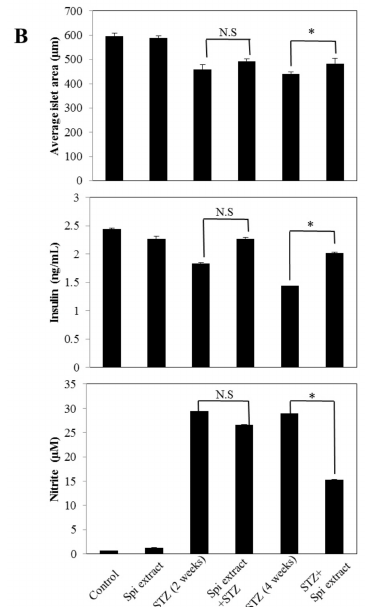
Figure 7. Spirulina extract protects islets from STZ-induced destruction. Type 1 diabetes was induced in Wistar rats through injection of STZ. ( A ) The cellular morphologies of islets were determined through staining with H&E. Islets were labeled with insulin antibody and nitrotyrosine antibody, and then examined by microscopy; ( B ) The size of islets was determined by IMT i-solution software. Levels of insulin and NO production in the serum were determined. Values are expressed as the mean ± SEM for six animals in each group. The two-sample t -test was used to compare the results between the control group and treatment group. N.S = Not significant. * p < 0.05, significant difference between the STZ-injected groups and the Spi extract + STZ or STZ + Spi extract